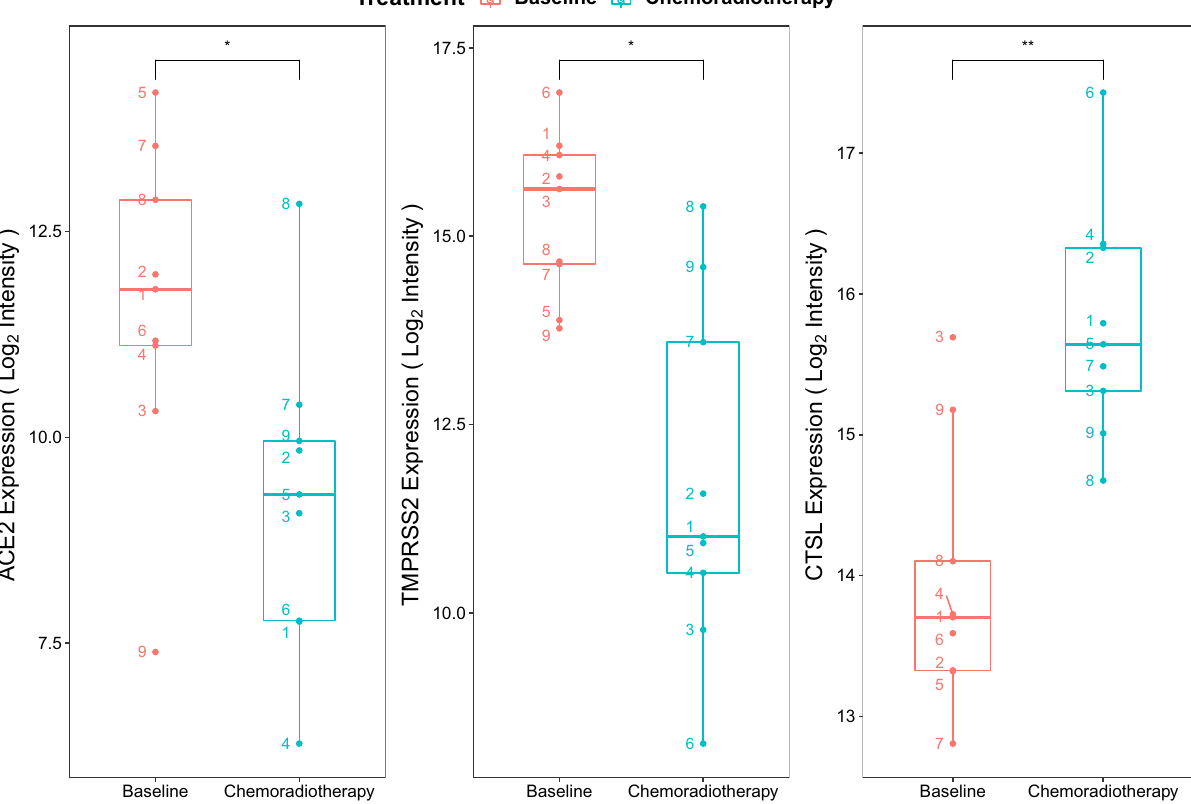
Figure 6. Effects of chemoradiotherapy on ACE2, TMPRSS2, and CTSL expression. Expression of ACE2 (left) , TMPRSS2 (middle) , and CTSL (right) in rectal tissue before and after chemoradiotherapy with 50 Gy in 25 fractions over 5 weeks plus capecitabine 825 mg/m 2 twice daily during radiotherapy from the GSE15781 data set (n = 9 patients). The probe intensity for each gene was log 2 transformed and visualised for each treatment group to present normalized gene expression values. Paired t-tests were performed between time points and significant differential expression between groups was labelled. The numbers denote each of the 9 individual patient’s data points. * p < 0.05. ** p < 0.01 between baseline and chemotherapy